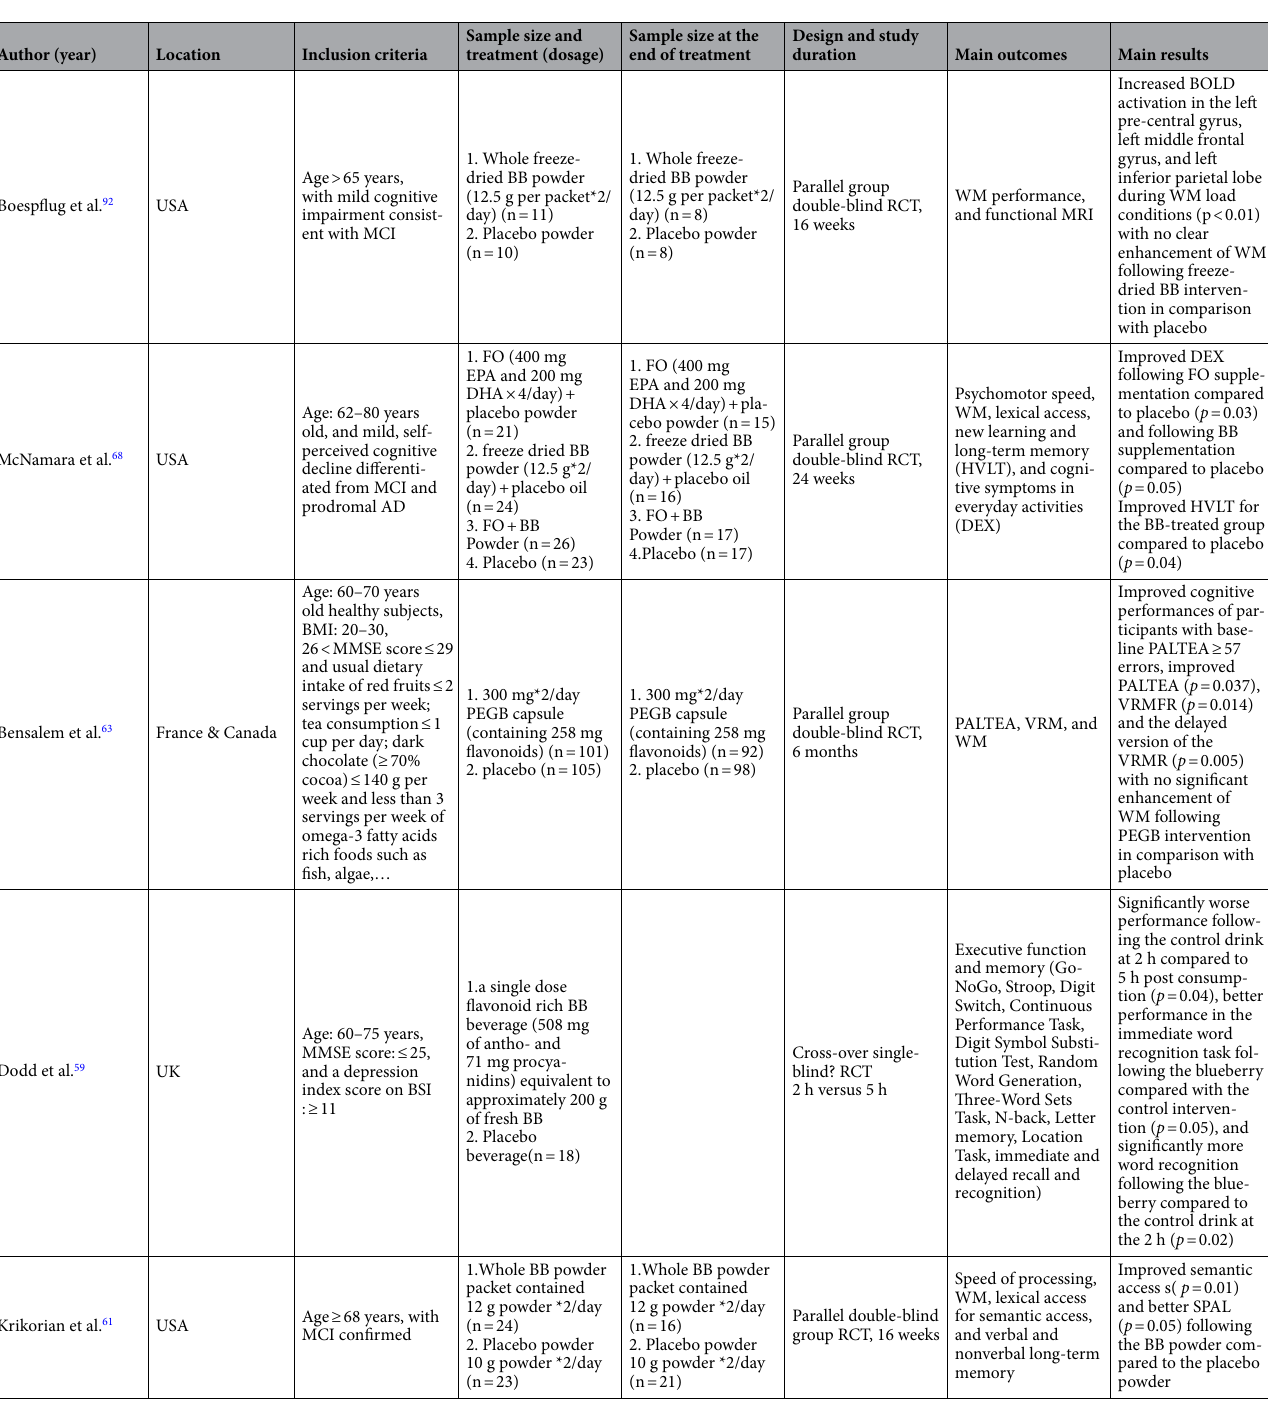
Table 2. Included randomized controlled trials of berry-based food interventions on cognitive function. AD: Alzheimer’s disease ‘AN: Attention Network Task, BB:blueberry, BMI: body mass index, BSI: the Brief Symptom Inventory, CVLT: the California Verbal Learning Task, CVLT-II: California Verbal Learning Test, 2nded, DEX: Dysexecutive questionnaire, DS: digit span, FO: fish oil; GDS: Geriatric Depression Scale, HVLT: Hopkins Verbal Learning Test, MCDR: modified Clinical Dementia Rating, MCI: mild cognitive impairment, MMSE: a Mini Mental State Examination, MoCA: Montreal Cognitive Assessment, PAL: Paired